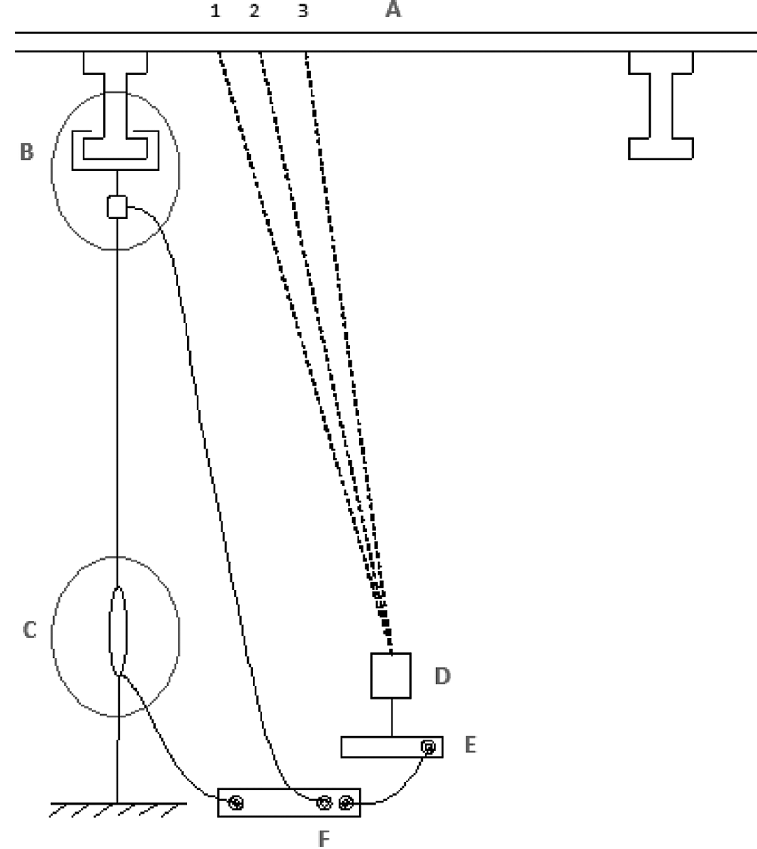
Fig. 3. Schematic representation of the measurement setup. A: Tested ceiling structure with scanned measurement grid (1,2, ... , 72), B: Joist and its connection with the PAM (Fig. 4), C: PAM system (Fig. 5), D: Laser head, E: SLDV decoder, F:Computer with generator and acquisition system.